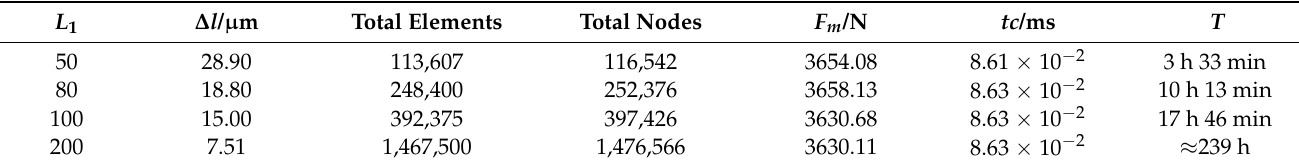
Table 2. Contact convergence analysis.